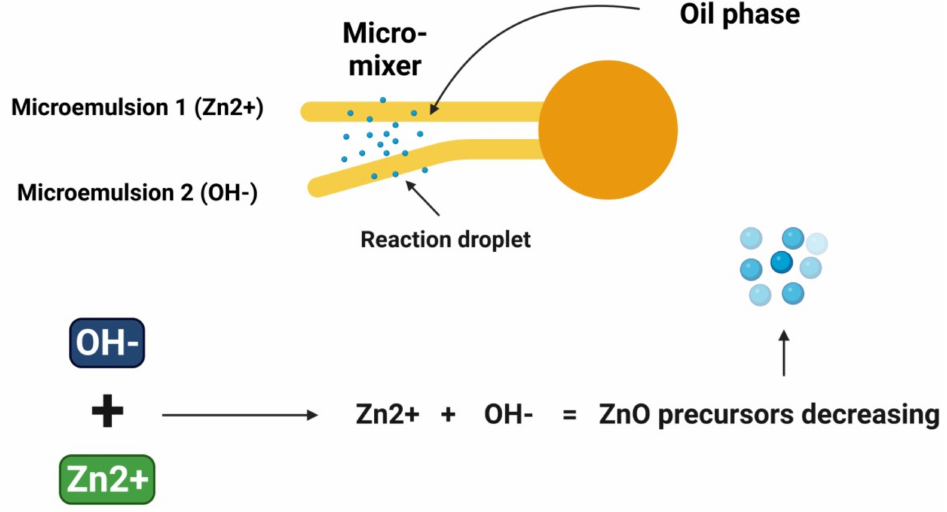
Figure 6. Diagrammatic representation of the stages required for metallic ZnO-NPs synthesis em- ploying the microemulsion